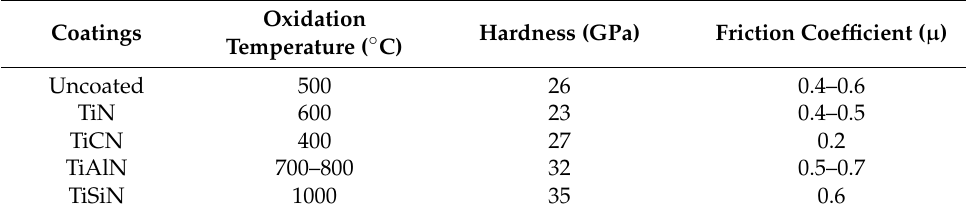
Table 1. Properties of cutting tools [27,29,30].